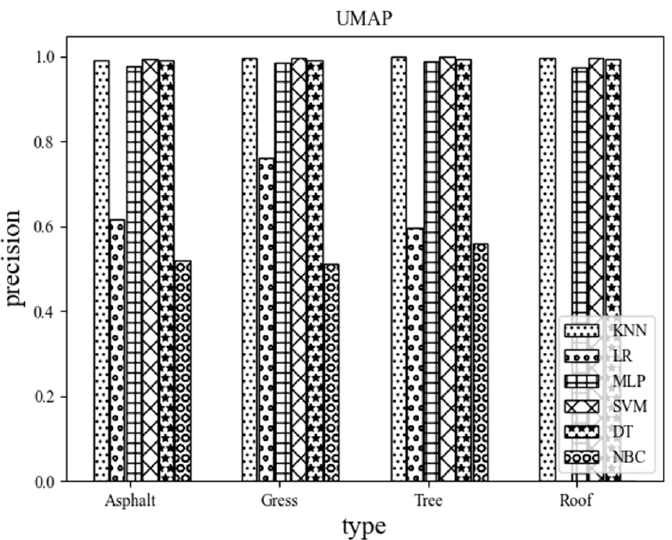
Figure 9. Comparison chart of terrain classification accuracy by UMAP dimensionality reduction.